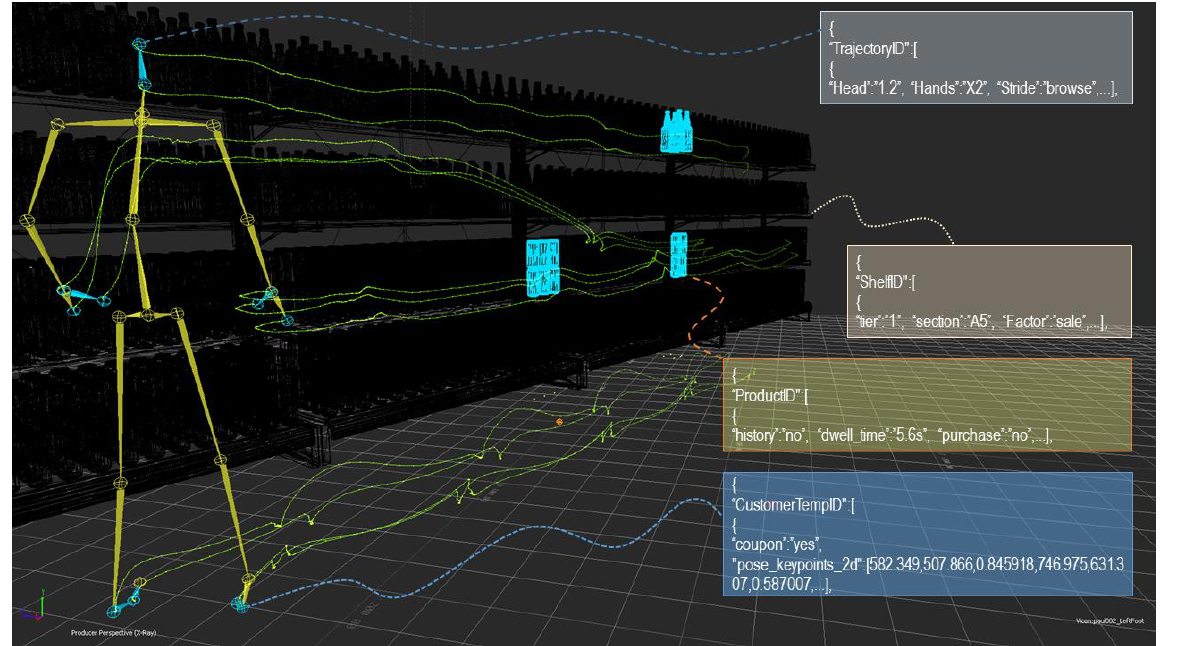
Figure 9. Very high-resolution matching between (1) store shelf geography, (2) products located on those shelves, (3) customer body language, (4) touchpoints with specific products and product groupings, and (5) the customer’s trajectory through the aisle space/servicescape. (The data to inform geo-targeting at this resolution can come from computer vision and deep learning, in real-time over Wi-Edge, as shown in Figure 8).